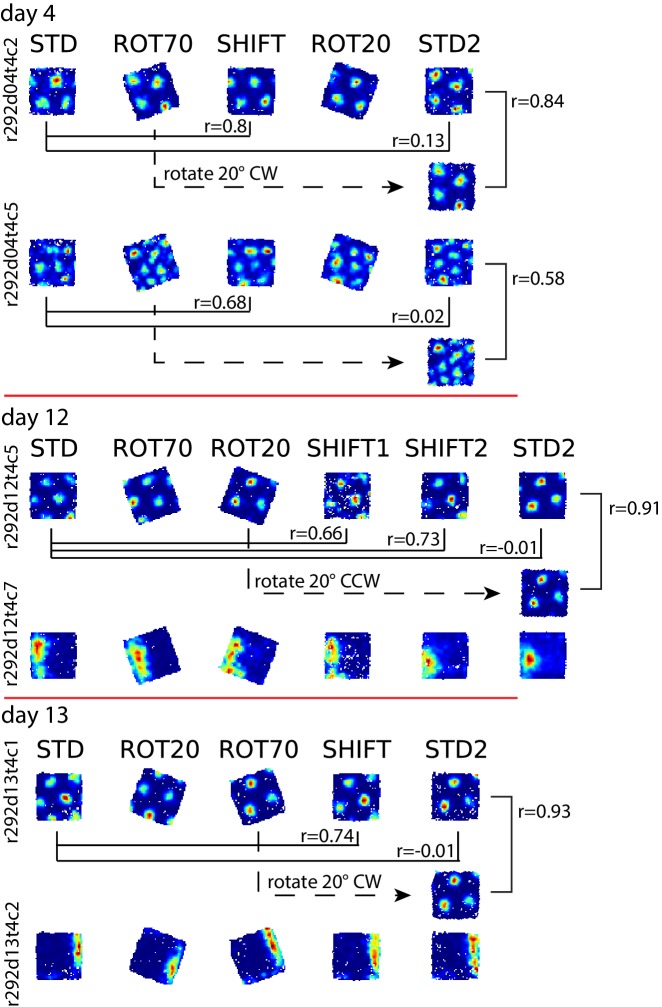
Bistable anchoring of grids across reference frames and experimental sessions in rat 292.All sessions are illustrated for grid cells recorded on the days when STD2 was run, in addition to the two cells in Figure 6B. Illustration and notations follow Figure 6B. In all examples, the alignment of the grid relative to the platform boundaries in STD2 differed from the alignment in STD but was the same as in a previous manipulation. The manipulation inducing the realignment affecting STD2 always preceded the SHIFT condition, regardless of the type of manipulation and the manipulation sequence. The STD2 session always inherited this orientation, even as markedly different orientations were experienced over the 1–2 intervening sessions. On Days 12, and 13, boundary cells were recorded simultaneously with the grid cells, similar to Figure 6B.